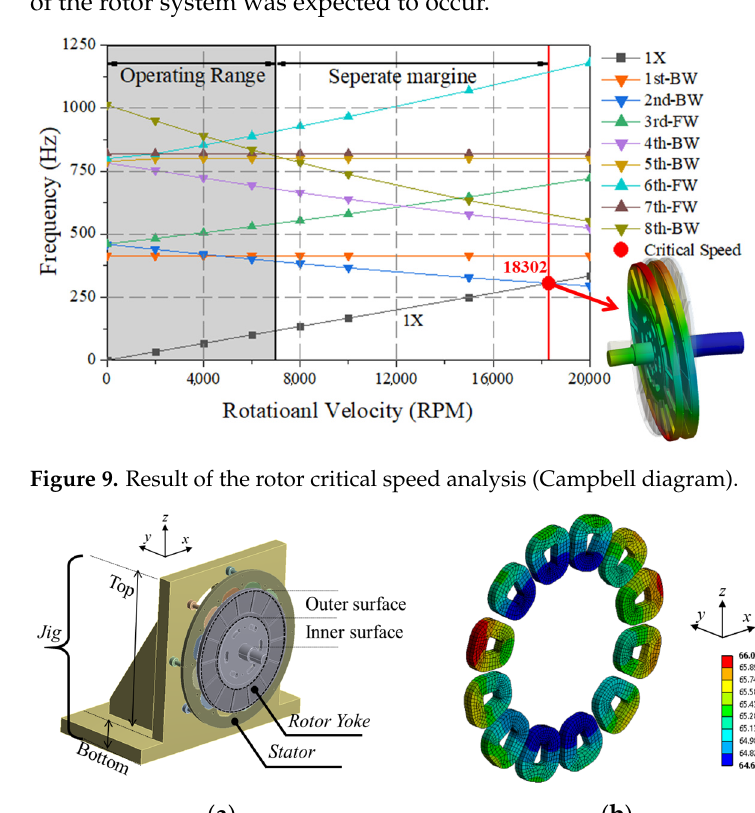
Figure 8. ( a ) Structure of the rotor; and ( b ) stress analysis result for the rotor frame.